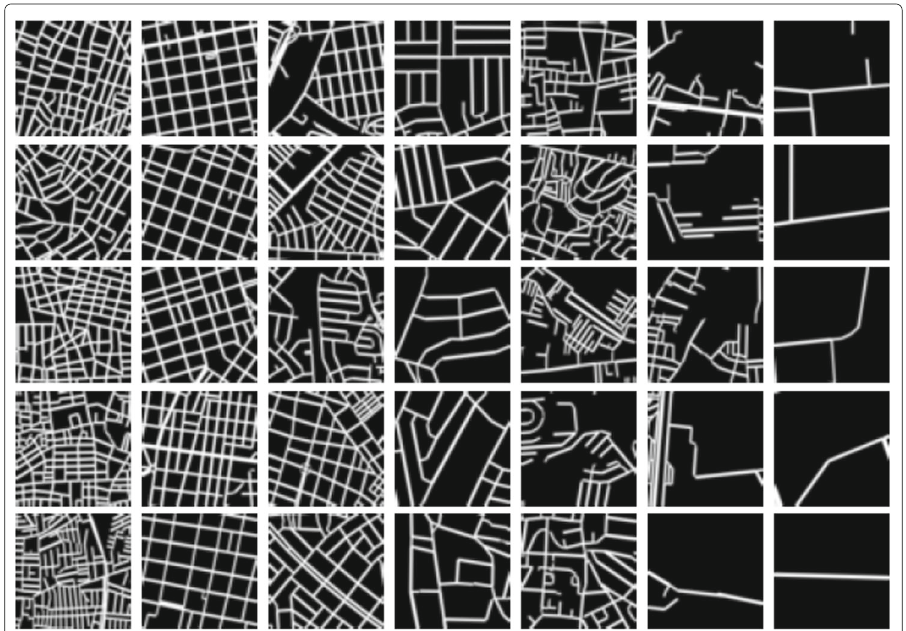
Fig. 5 Street network images (top row) with most similar street networks (rows below) based on the Euclidean distance between their urban network vectors. The latent representations, obtained using